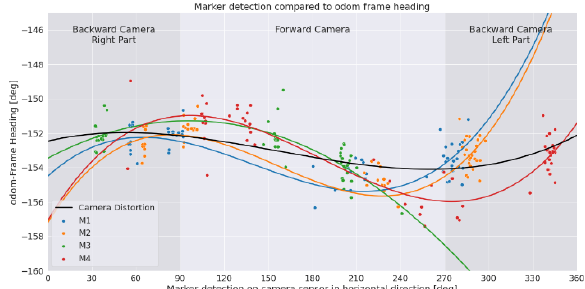
Figure 13. Comparison of position of the marker detection on the camera sensor to odom frame